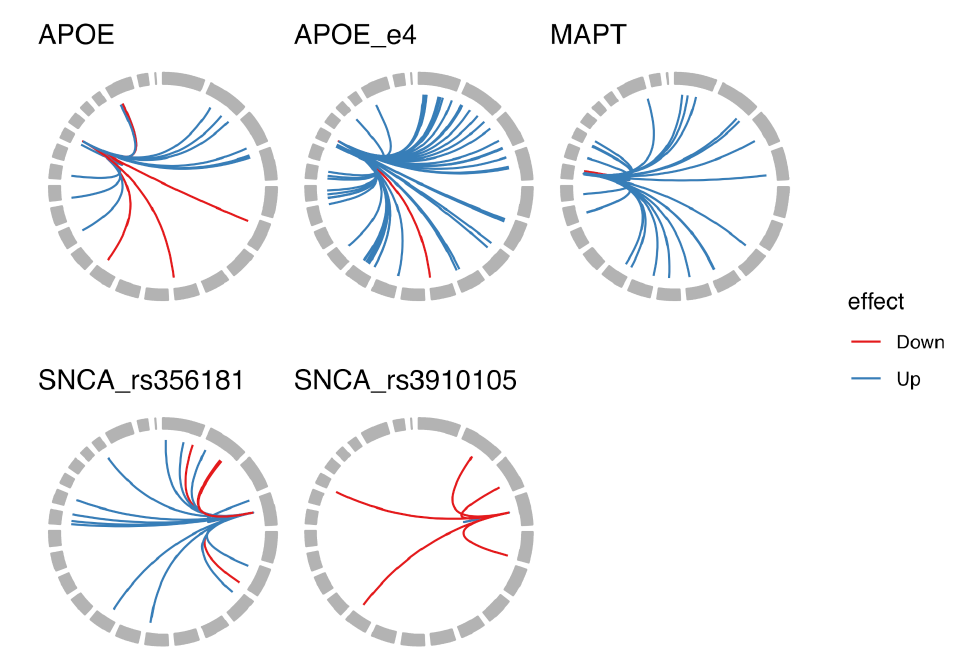
Figure 1. Combined Circos plot describing the regulatory effects of all studied loci. Each locus is shown in a separate panel with cis and trans activities combined into single circus plot. Down or up-regulating effects are shown with red and blue colour, respectively. Some loci had dominatingly up-regulating effects, while the one locus had mainly down-regulating